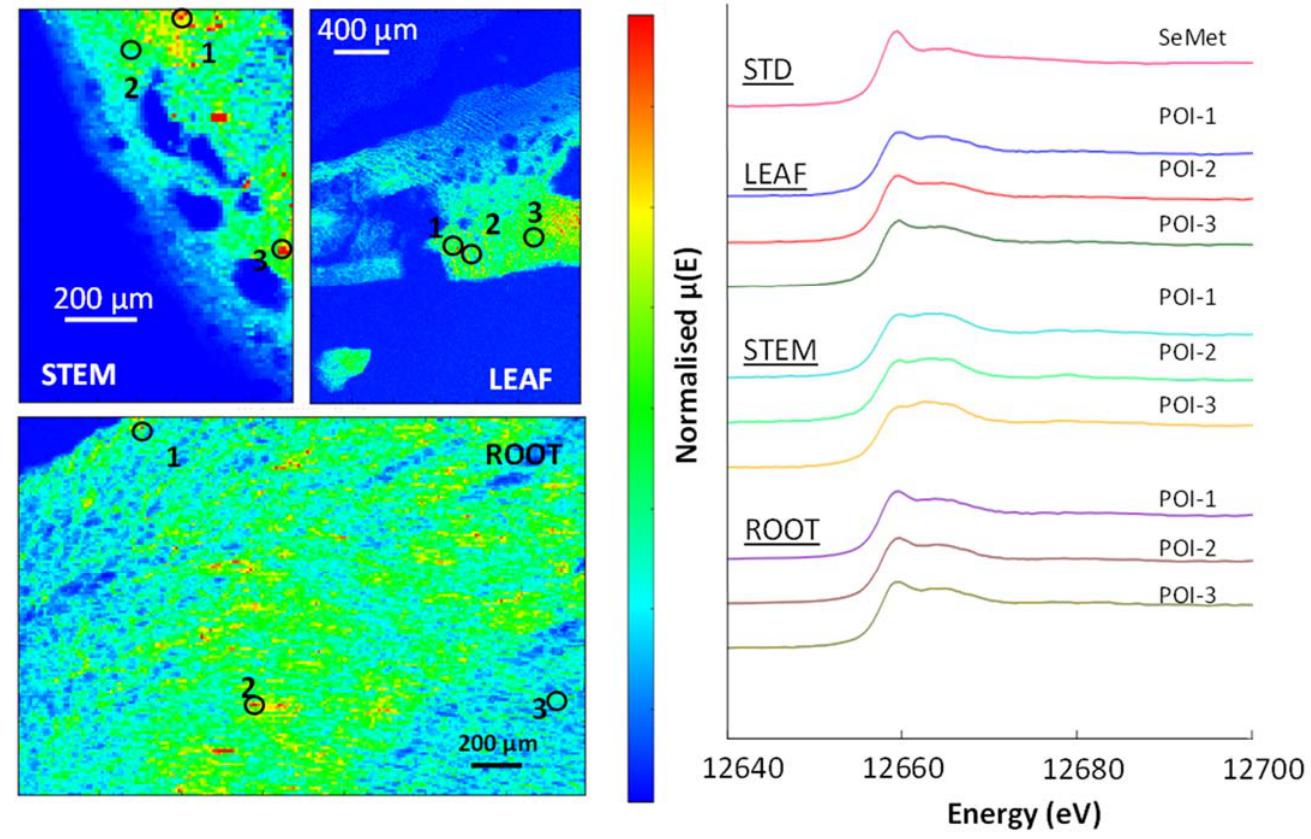
Figure 9. ( Left ): µ -XRF Se K -edge maps showing cross-sections through a premier kale leaf, stem and root. The µ -XRF is on a temperature scale, with high selenium counts in red and areas with no counts in dark blue. ( Right ): normalised XANES spectra showing selenium species in selected POIs and the SeMet standard. Table 5. Linear combination fits for points of interest (POIs) selected in the seleniferous horizon (30–40 cm) of two soils from West Limerick. The goodness of fit is determined by the R ‐ factor (approximate error ±3%). (Note: there was no detectable selenate).